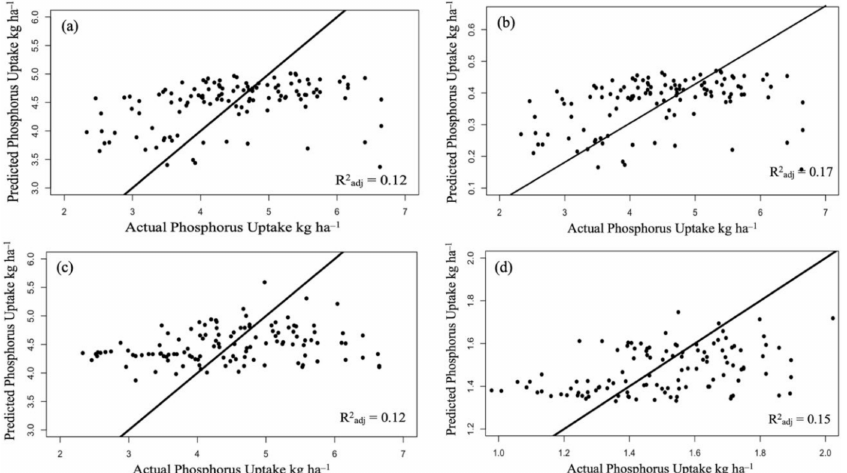
Figure 9. Relationship between the actual and predicted phosphorus uptake for ( a ) the third flight on 9 July, the untransformed model; ( b ) the third flight on 9 July, the transformed model; ( c ) the sixth flight on 29 July, the untransformed model; ( d ) the sixth flight on 29 July, the transformed